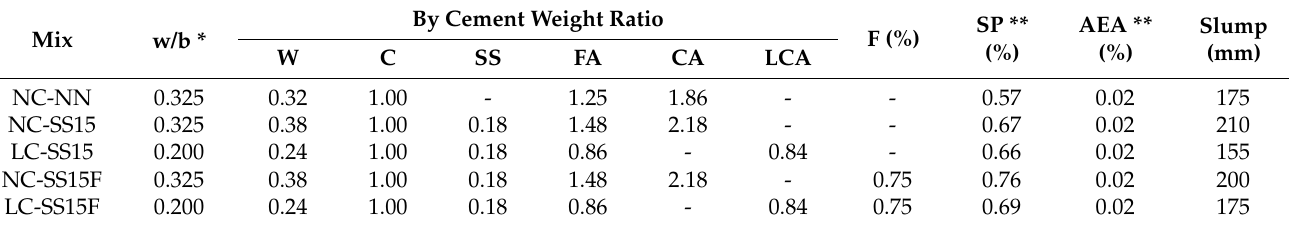
Table 1. Mix design of concrete specimens.